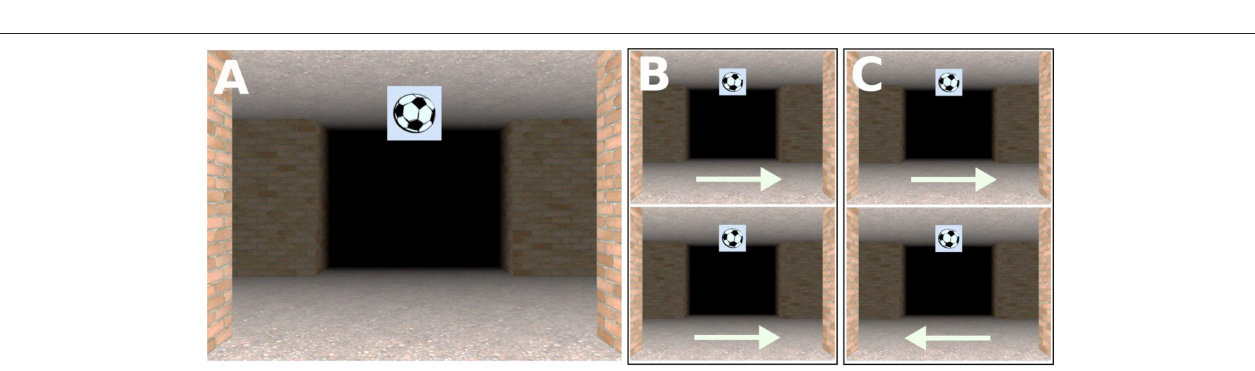
FIGURE 1 | Left: The 18 landmark objects used in the routes; Middle: Schematic drawing of the different direction route ; Right: Table summarizing the same direction and the different direction route in detail. Int#: Number of intersection; Turn: Direction of turn left (L), right (R), straight (S); Unique: Unique (U), or non-unique (Non-U) object at intersection; Route: Two route conditions; Same: Direction of turn is the same for pairs of non-unique intersections; Diff: Direction of turn is different for pairs of non-unique intersections.